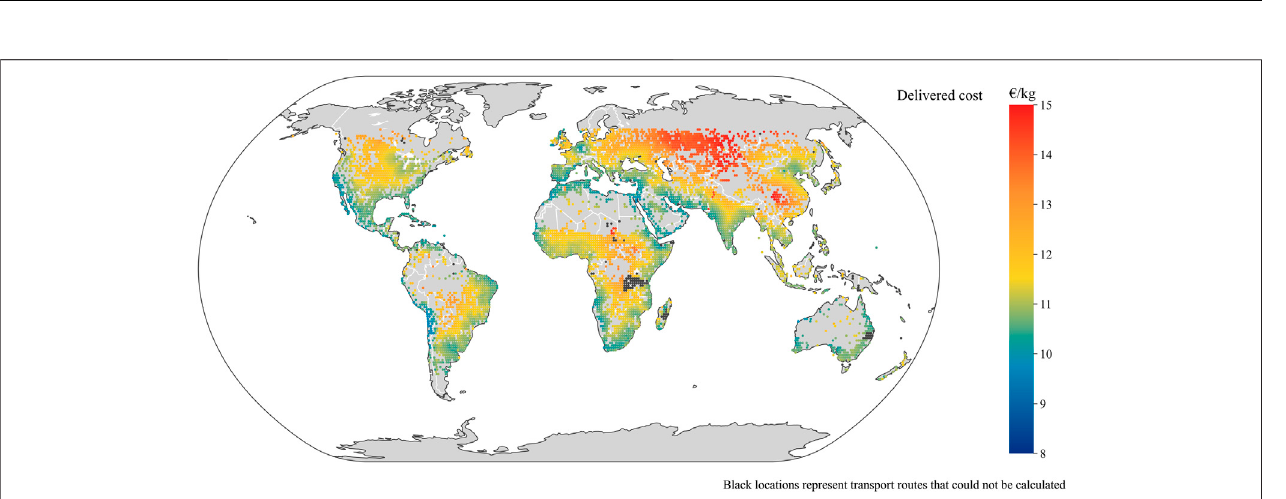
Frontiers in Energy Research |